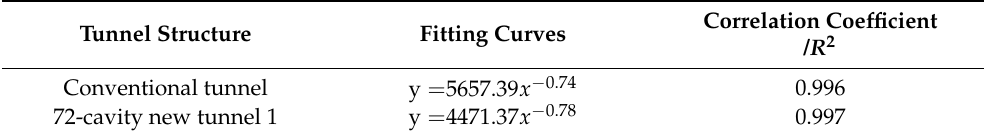
Table 6. Micro-pressure wave fitting curves for different tunnel